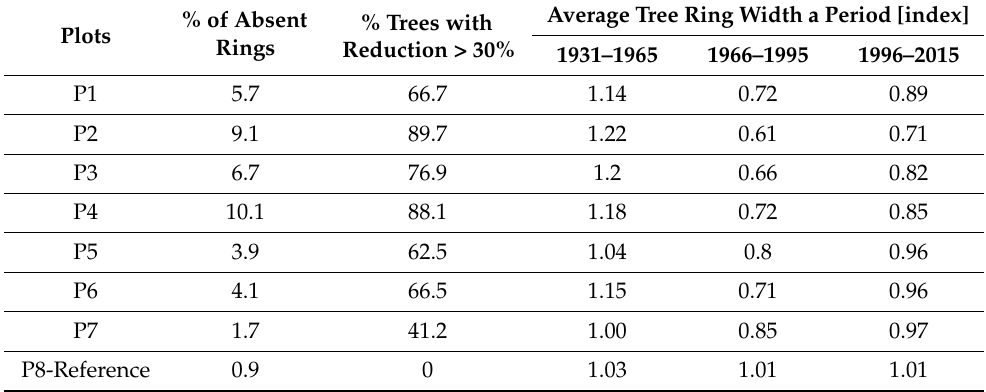
Table 1. Characteristics of tree-ring chronologies, and results of calculation of growth changes under influence of air pollution from the nitrogen fertilizer factory in Puławy. % of Absent % Trees with Plots Rings